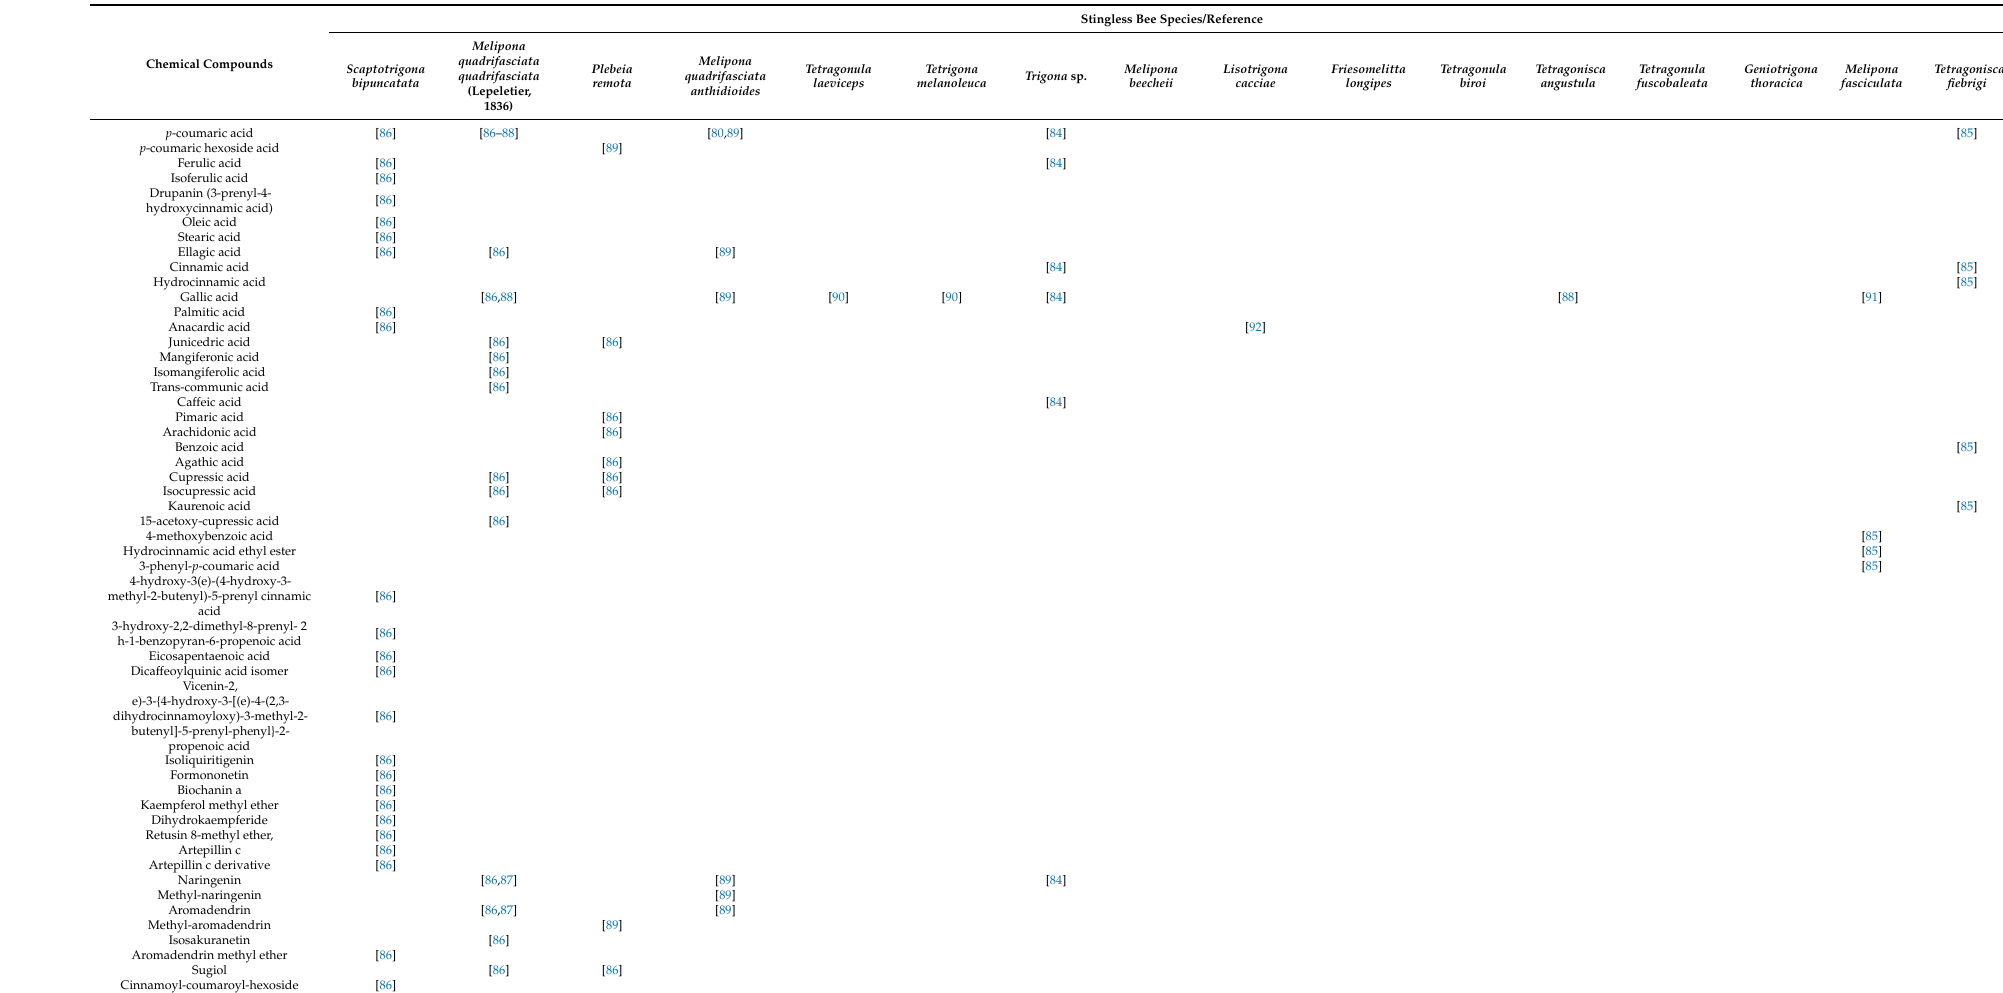
Table 5. Stingless bee propolis chemical